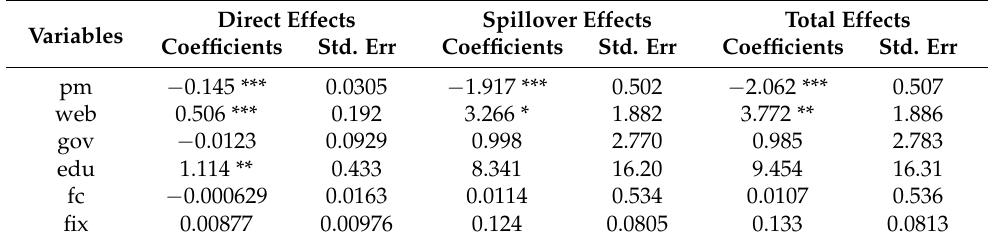
Table 7. Robust test using a different weight matrix.